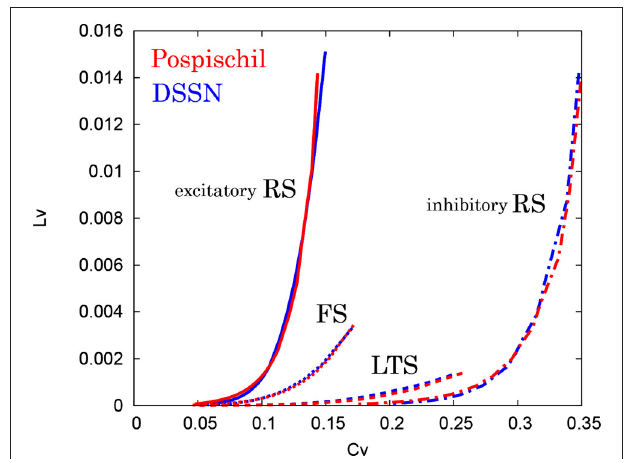
FIGURE 13 | C V − L V characteristics in the RS, FS, and LTS classes. The C V − L V characteristics of the Pospischil (red) and the DSSN (blue) models in the excitatory and inhibitory RS, FS, and LTS classes.